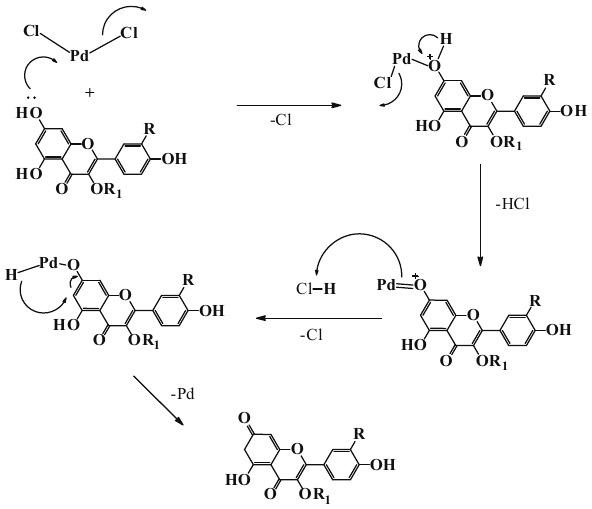
Figure 7: Possible process of Pd 2 + reduction to Pd 0 by fl avonoids in Gymnema sylvestre leaf extract to produce GSE - PdNPs.